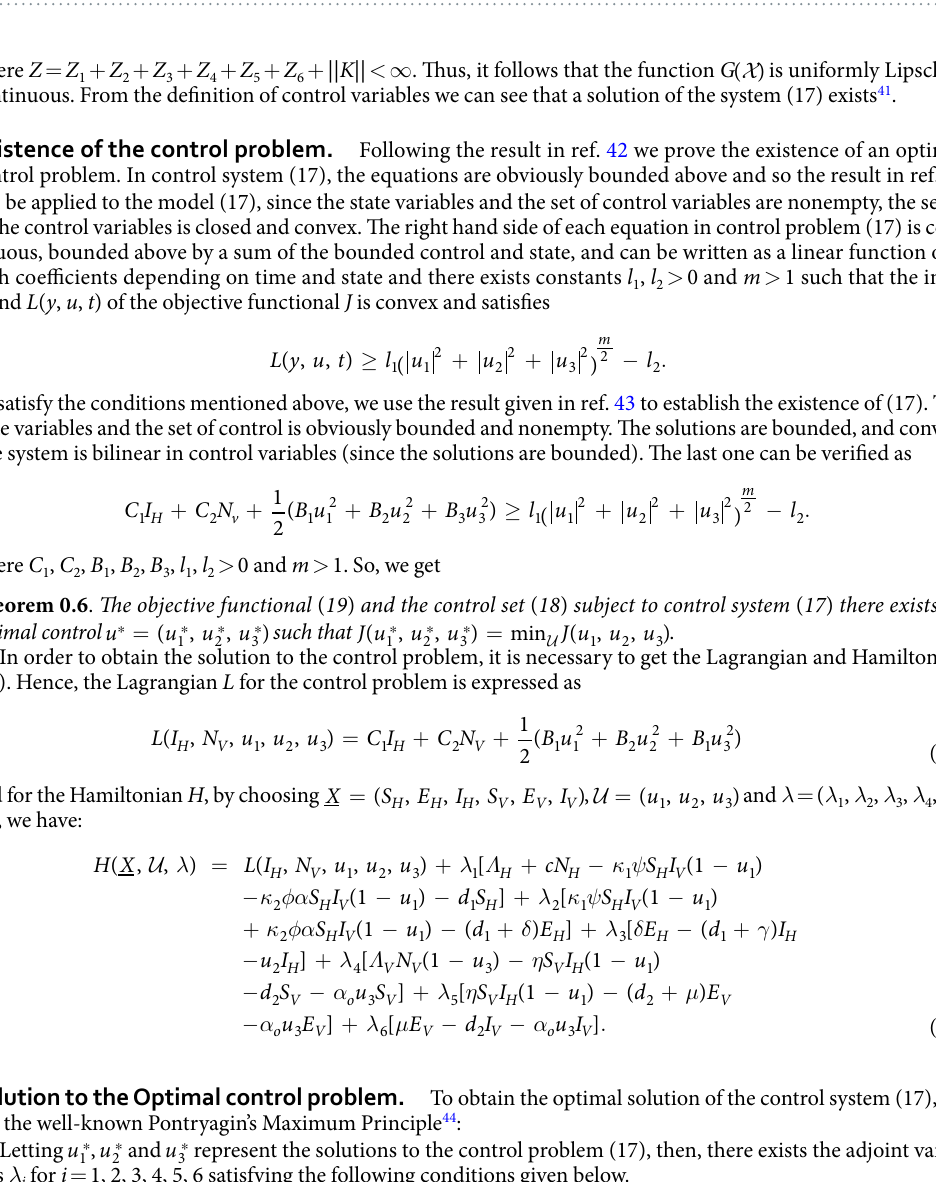
Table 1. Values of parameter used in numerical simulation of the optimal control